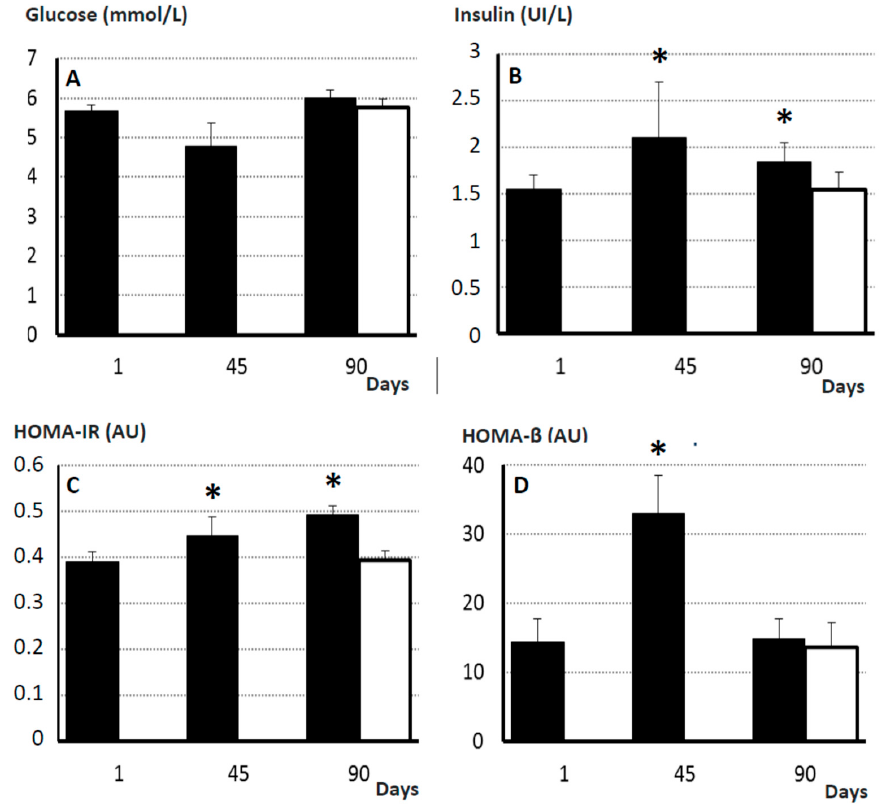
Figure 4. Mean ( ± S.E.M.) plasma concentrations of glucose ( A ) and insulin ( B ) and values for HOMA-IR and HOMA- β indexes ( C and D , respectively) in control sows (white bar; n = 17) and changes in such values over time after starting differential feeding with a diet enriched with saturated fat in treated sows (black bars; n = 11). Asterisks (*) denote significant differences between obese and non-obese sows ( p < 0.05).